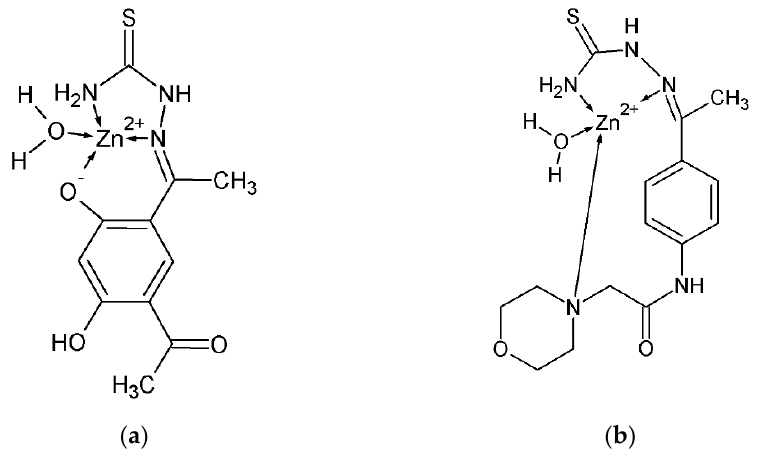
Figure 3. ( a ) Structure of (T-4)-[2-[1-[5-Acetyl-2-(hydroxy- κO) -4-hydroxyphenyl]ethylidene]hydra- zinecarbothioamidato(2-)- κN,κN2]aquazinc according to [20], redrawn by ACD/ChemSketch; ( b ) Zn 2+ complex of 24-8-1 , i.e., 4-[(morpholine-4-yl)acetamido]acetophenone thiosemicarbazone as an example of the possibility of the coordination of the prepared Schiff bases with Zn